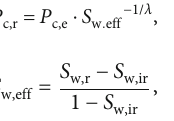
Figure 4: Changes in residual capillary pressure ( P ) when injected with (a) gCO c,r result in Pini and Benson (2013) for injection of CO in Berea sandstone from 0 o to 90 o of each phase. Note that residual saturation of 2 brine and CO is denoted in S and S , w,r CO 2 2